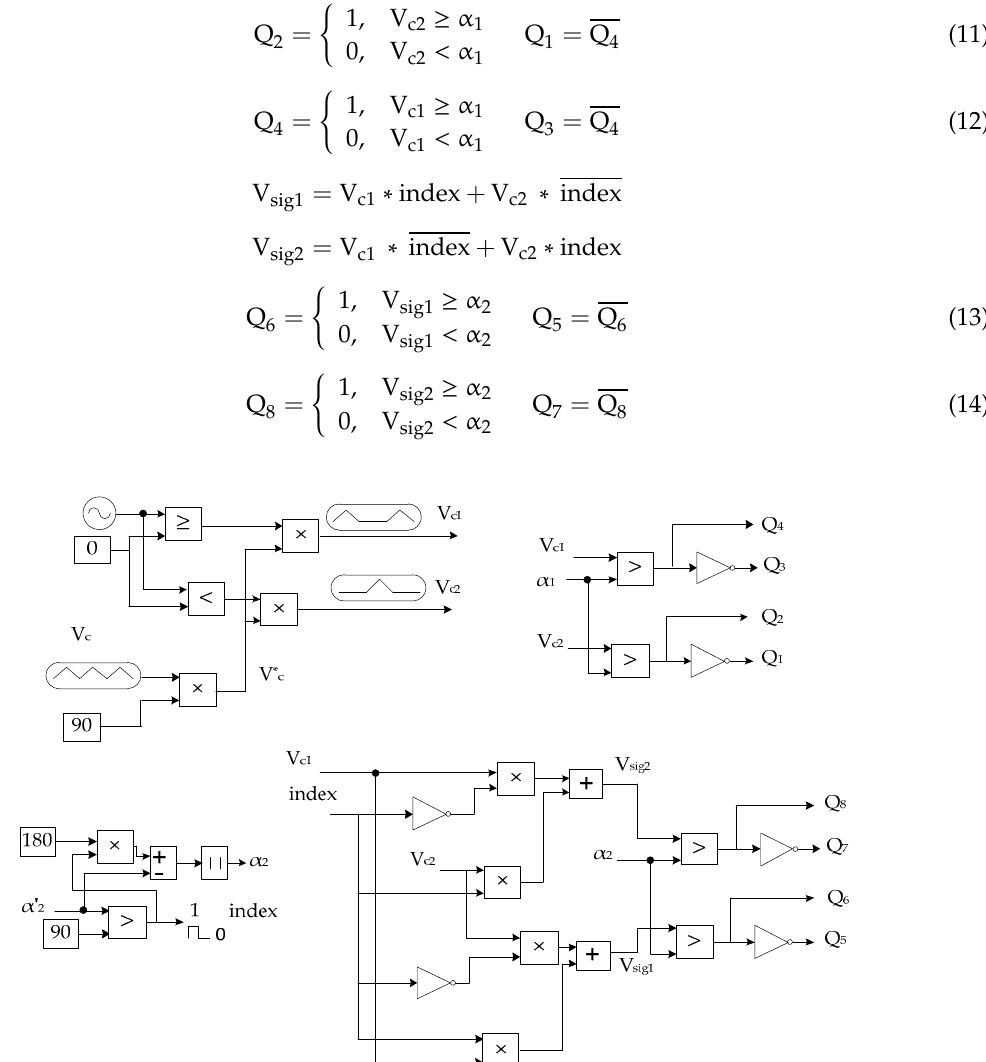
Figure 4. Logic for the gate pulse generation of the proposed control technique.